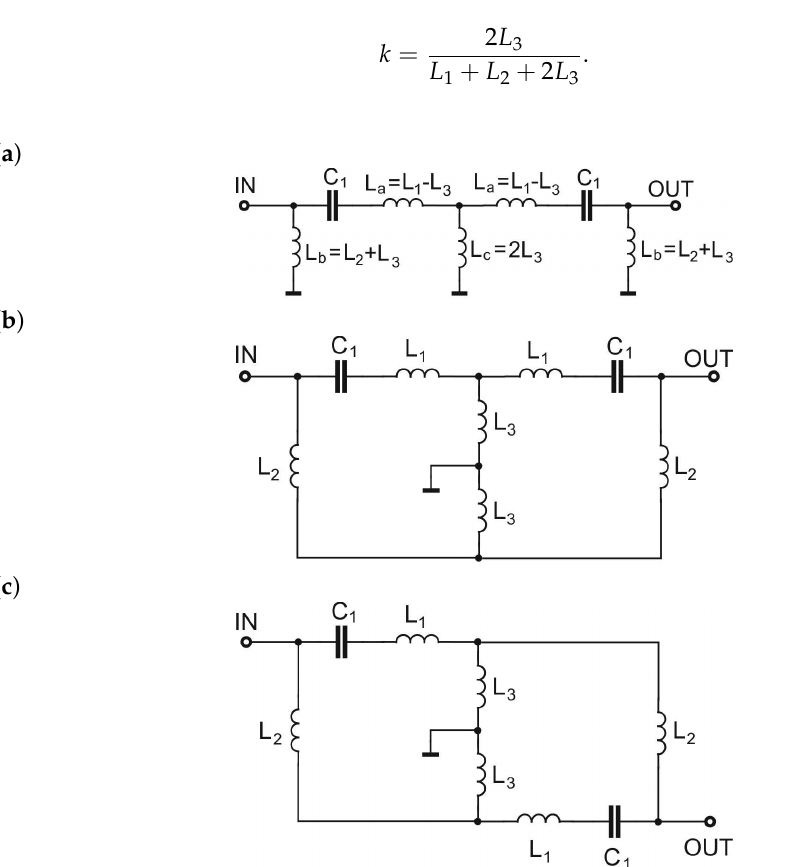
Figure 1. Lumped element bandpass filters: ( a ) the initial circuit of the double-tuned coupled resonator filter, ( b ) the filter with a split coupling inductance, and ( c ) the filter with swapped branches within the output